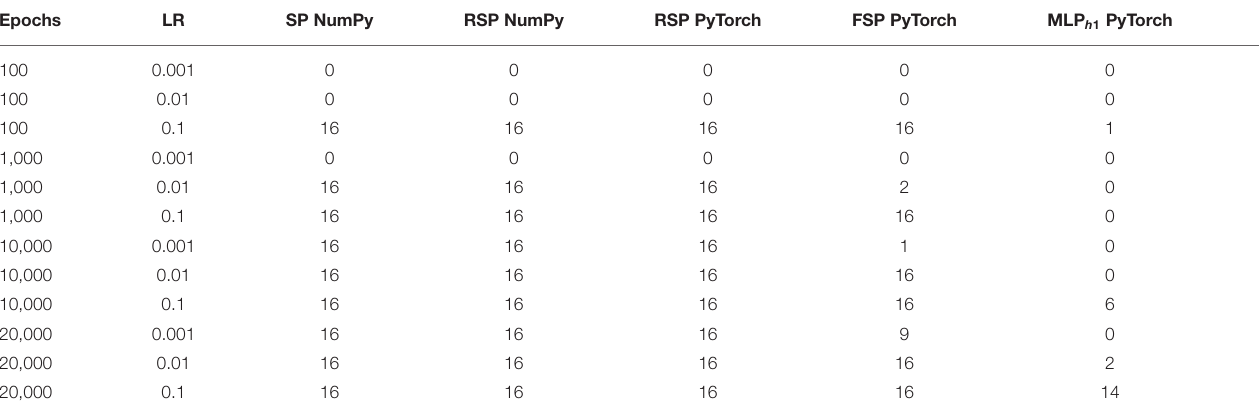
TABLE 5 | Number of learned functions per method when learning the sixteen functions of the binary Boolean function Space.